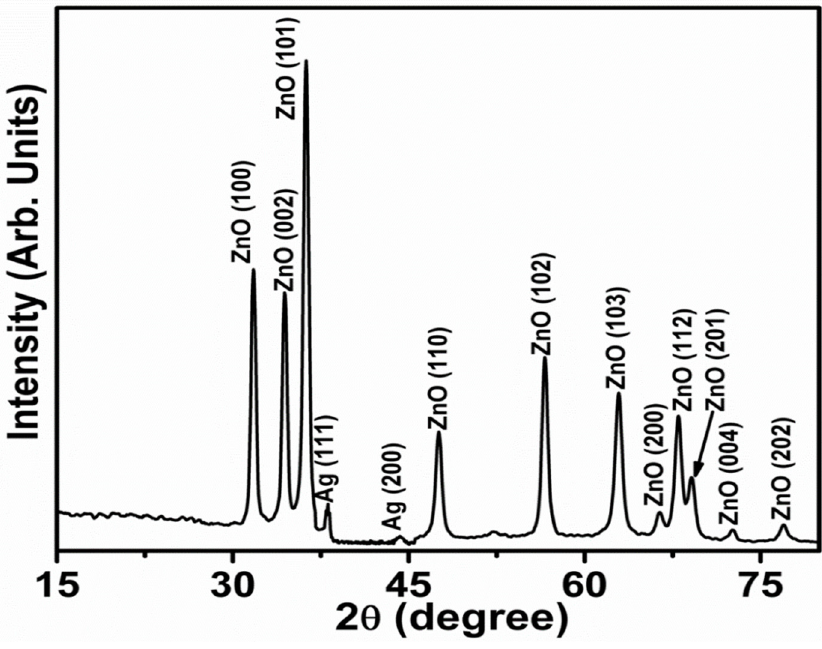
Figure 1. Powder X-ray diffraction pattern of Ag-doped ZnO nanoflowers.